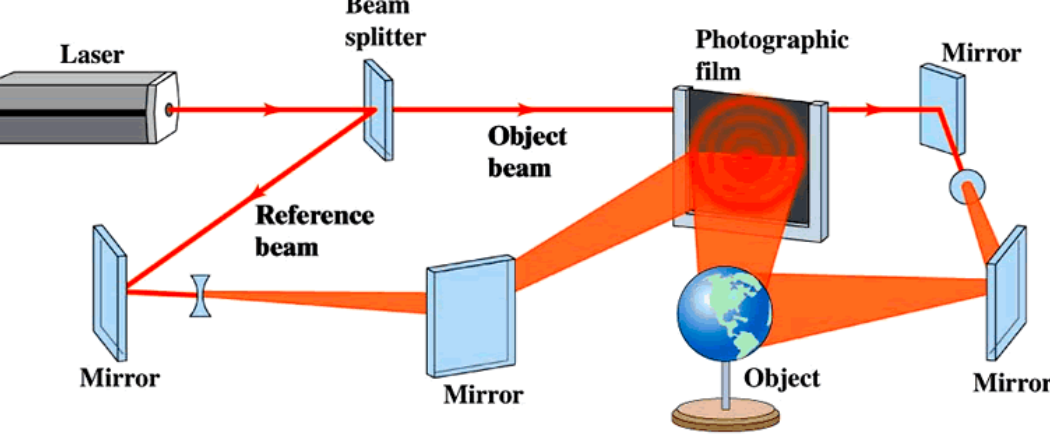
Figure 1. Scheme of the holographic setup and functioning .